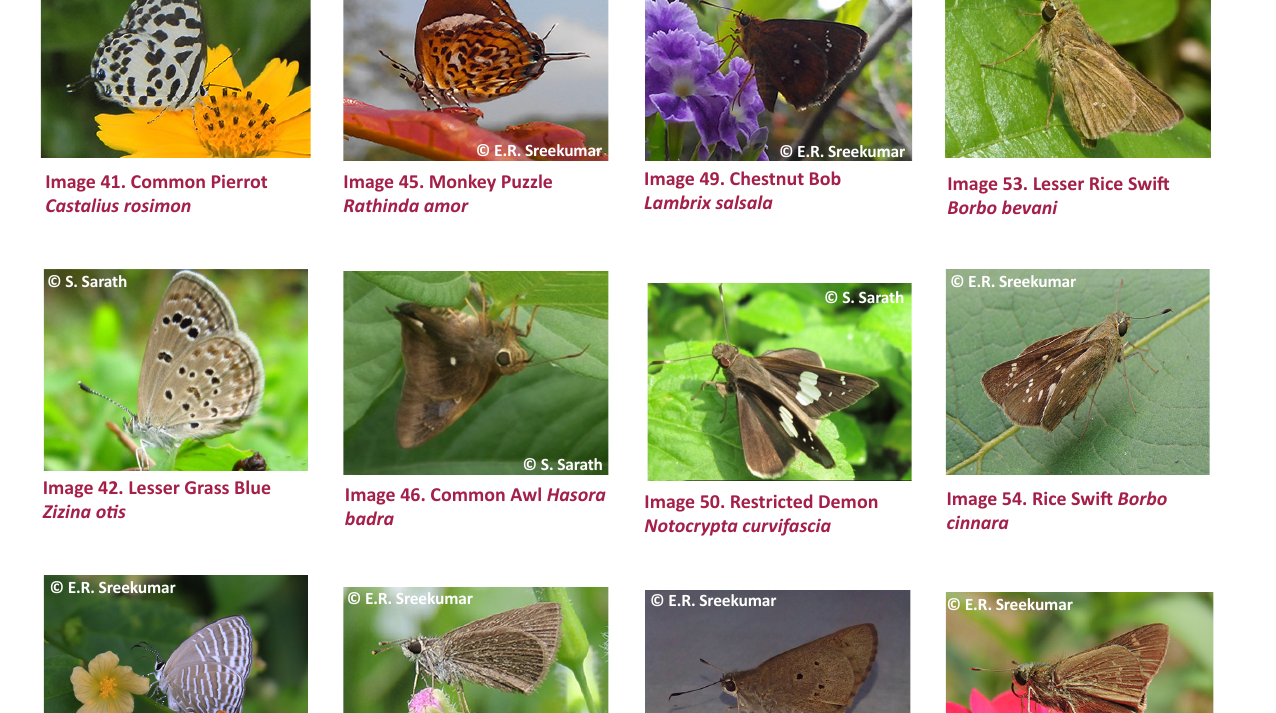
Image 47. Pygmy Scrub Hopper Image 43. Common Cerulean Aeromachus pygmaeus Jamides celeno ©